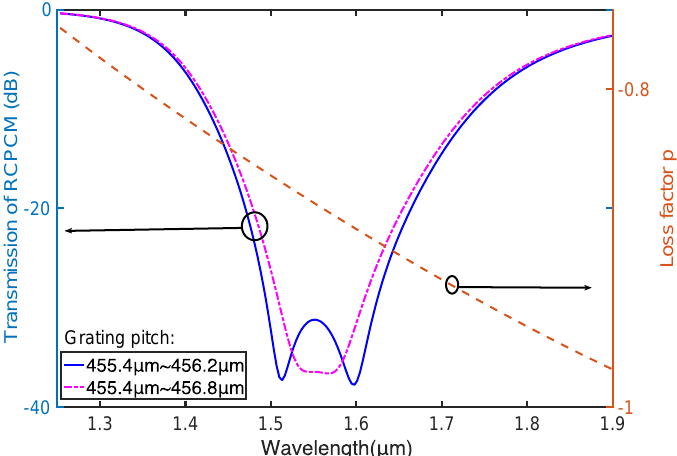
Figure 6. Transmission of the RCPCM and corresponding loss factor in coated chirped CLPG with a bandwidth of 100 nm.